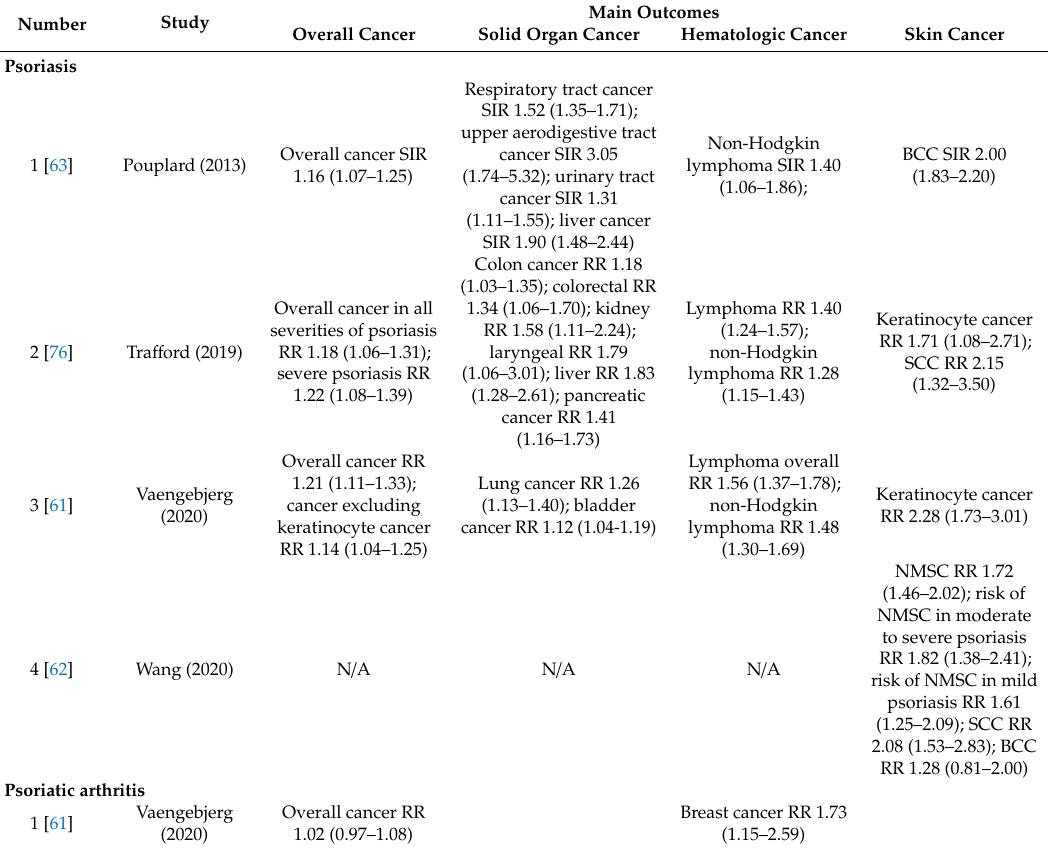
Table 3. Summary of the systematic review and meta-analyses identifying the risk of cancers in patients with psoriasis and psoriatic